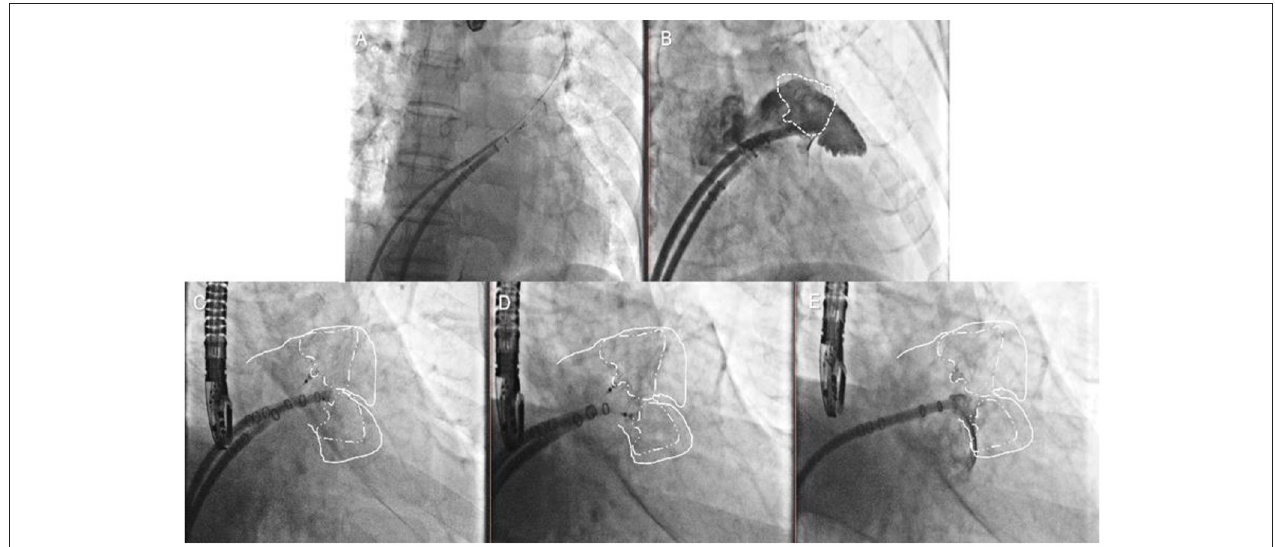
FIGURE 3 | Double-sheath strategy. Step 5 (A) the second transseptal puncture via the same femoral site; Step 6 (B) the selective angiography of the second lobe was made; Step 7 (C) the second Watchman device was chosen according to the uncovered lobe; Step 8 (D) the tug test was performed on the two devices simultaneously; Step 9 (E) the two devices were released after the PASS criteria had been met with both